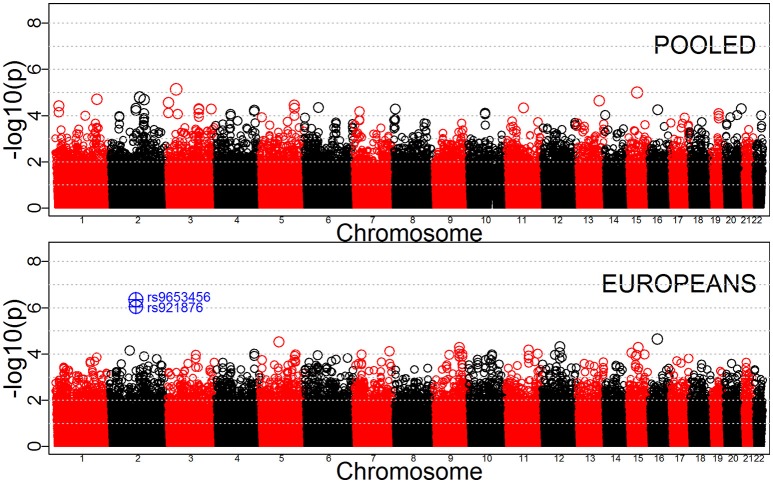
Manhattan plots for GxAlcohol effects in the pooled and Europeans-only analyses. SNPs with p-values below 10−6 are shown in blue.